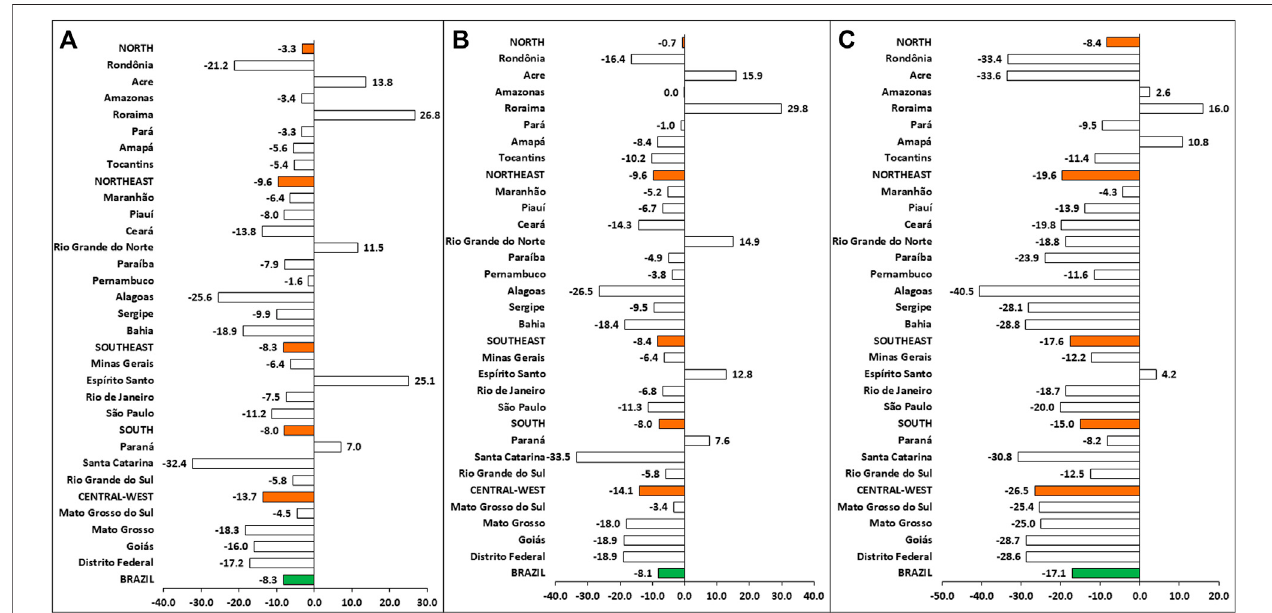
FIGURE1| Thepercentageofchangeoftuberculosiscases,accordingtodatafromBrazil(greenbars),Brazilianregions(orangebars),andstates. (A) %changein the new TB cases; (B) % change in the new PTB cases; (C) % change in the new baciloscopy-positive (AARB+) cases.